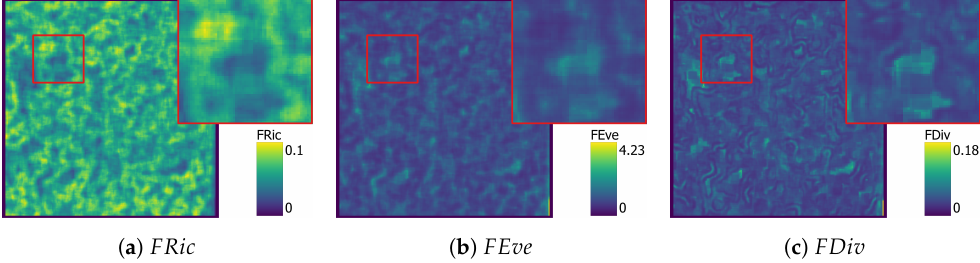
Figure 10. PCA, from nine traits, functional diversity maps with FRic , FEve , and FDiv in their own